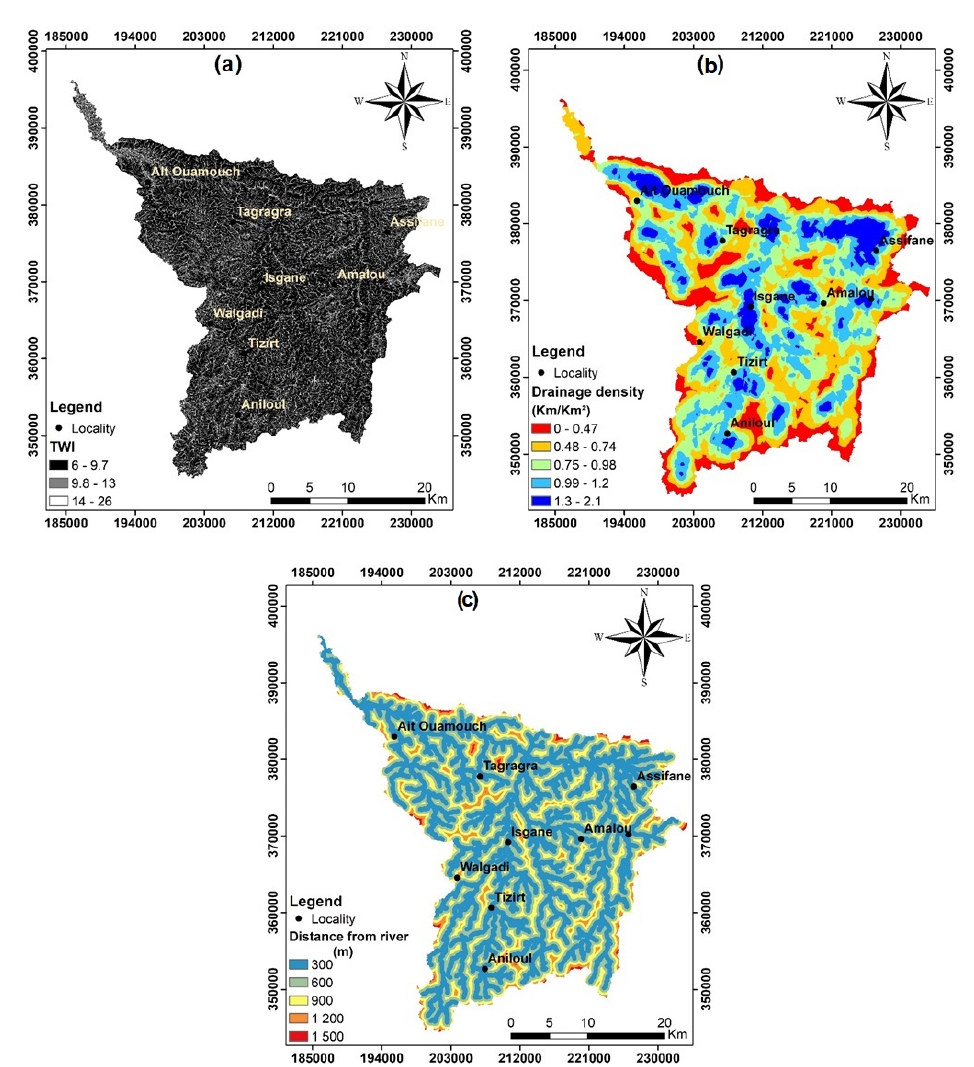
Figure 5. Hydrological factors influencing groundwater: ( a ) Topographic wetness index, ( b ) drainage density, ( c ) distance from river.